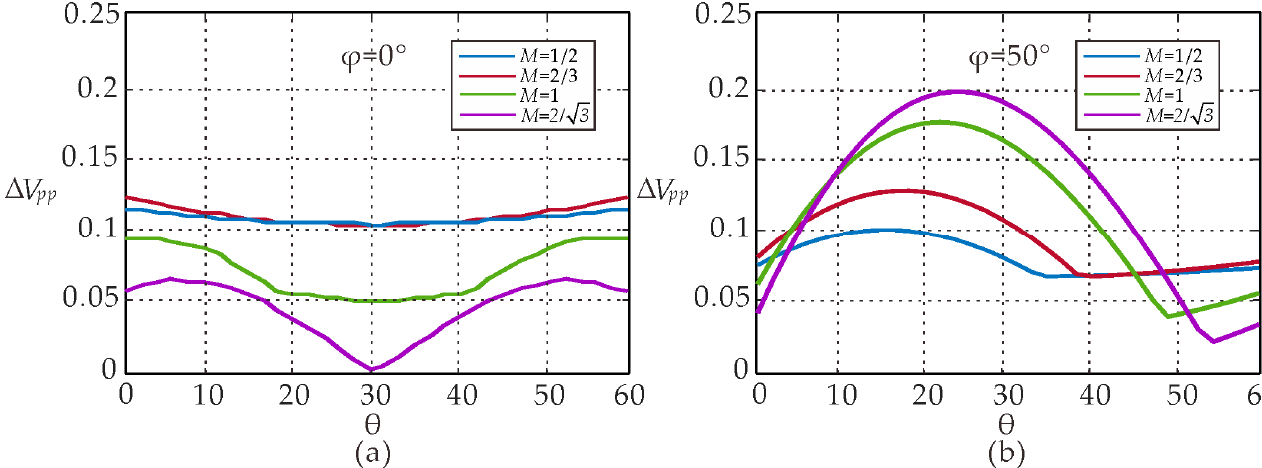
Figure 5. Normalized peak-to-peak dc-link voltage ripple amplitude Δ V pp over the period [0, 60°] for different modulation indices, M = 1/2, 2/3, 1, and 2/ 3 , and output phase angles ( a ) φ = 0° and ( b ) φ = 50°.